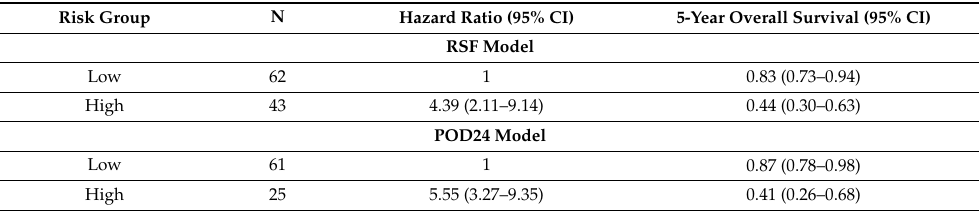
Table 4. Relative risk for the predicted high- and low-risk groups.